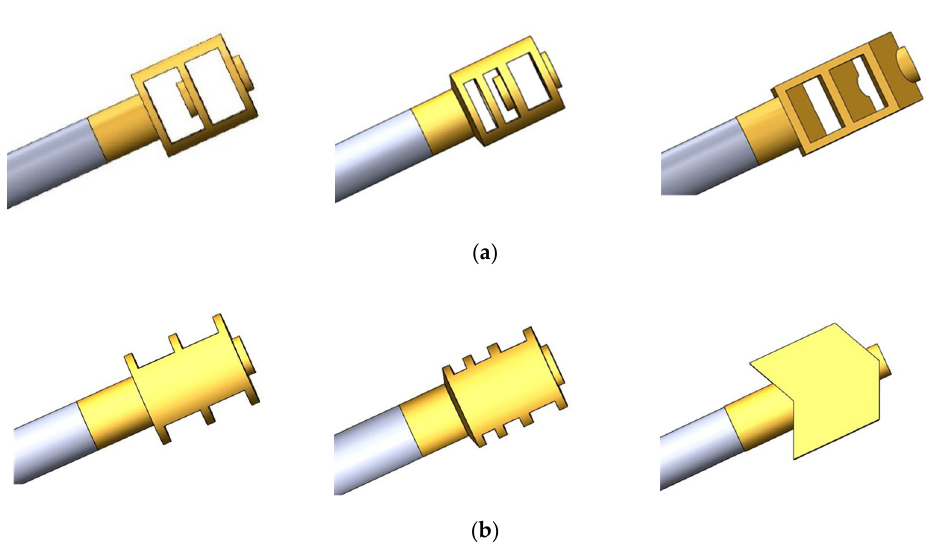
Figure 15. Schematic diagram of muzzle brakes with three different structures. ( a ) Side view. ( b ) Top view.